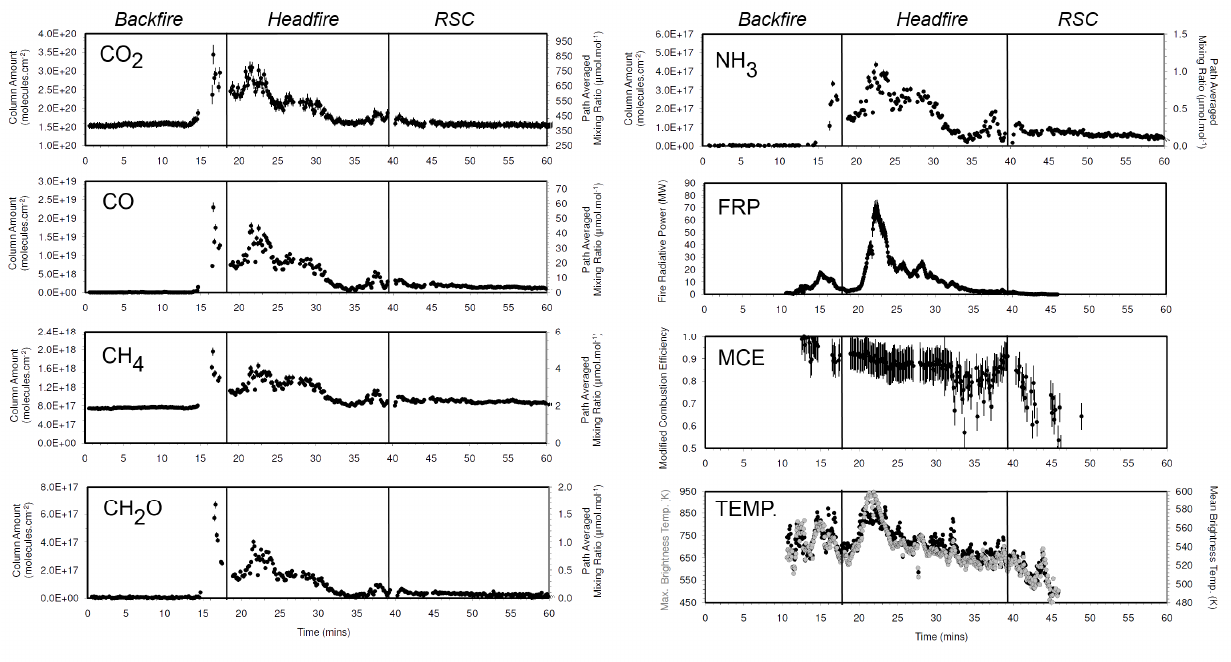
Fig. 6. Time-series of trace gas column amounts, Fire Radiative Power, Modified Combustion Efficiency (MCE) and fire temperature for Fire 1 (Figs. 1, 2 and 3 and Table 1). Trace gas amounts are expressed as path-integrated column amounts (moleculescm − 2 ), with the equivalent path averaged mixing ratio shown on the r.h.s. y-axis. After the 14:01h ignition time (time > 10min on this plot) these mixing ratios represent a weighted average of the pure plume and ambient air abundances (See Sect. 3.5). Error bars for the trace gas retrievals are calculated from the residuals of the best-fit forward modeled spectra (Horrocks et al., 2001), whilst those for FRP are calculated